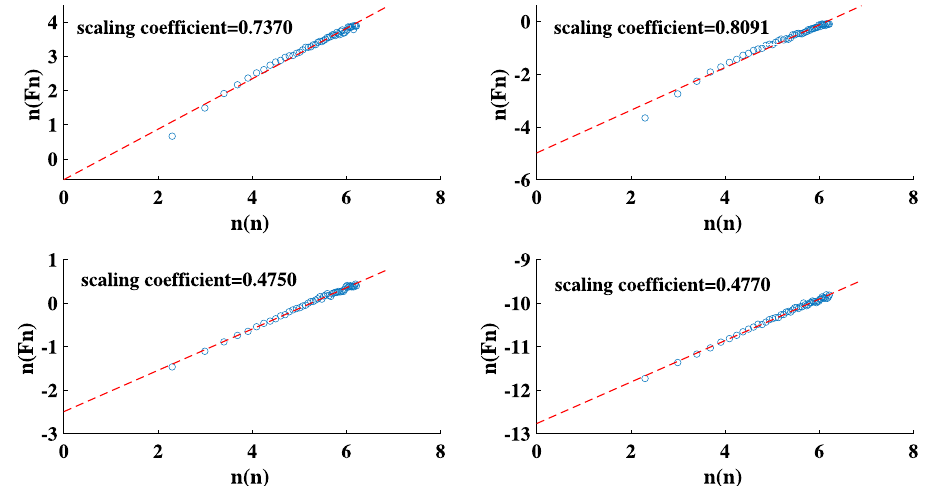
Figure 2. The scaling coefficient of the DFA for: the Bak sand-pile model (top left panel), Manna sand-pile model (top right panel), uniformly distributed random series (bottom left panel), and a normally distributed random series (bottom right panel).